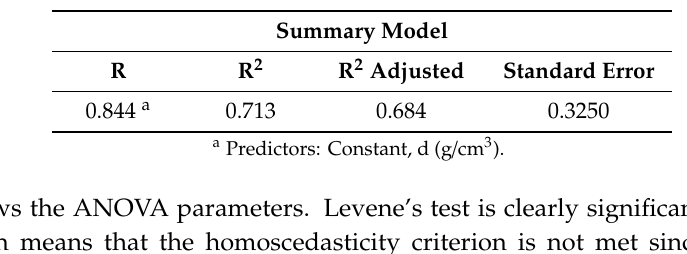
Table 4. Analysis of variance: In-situ density and topographic settlement.